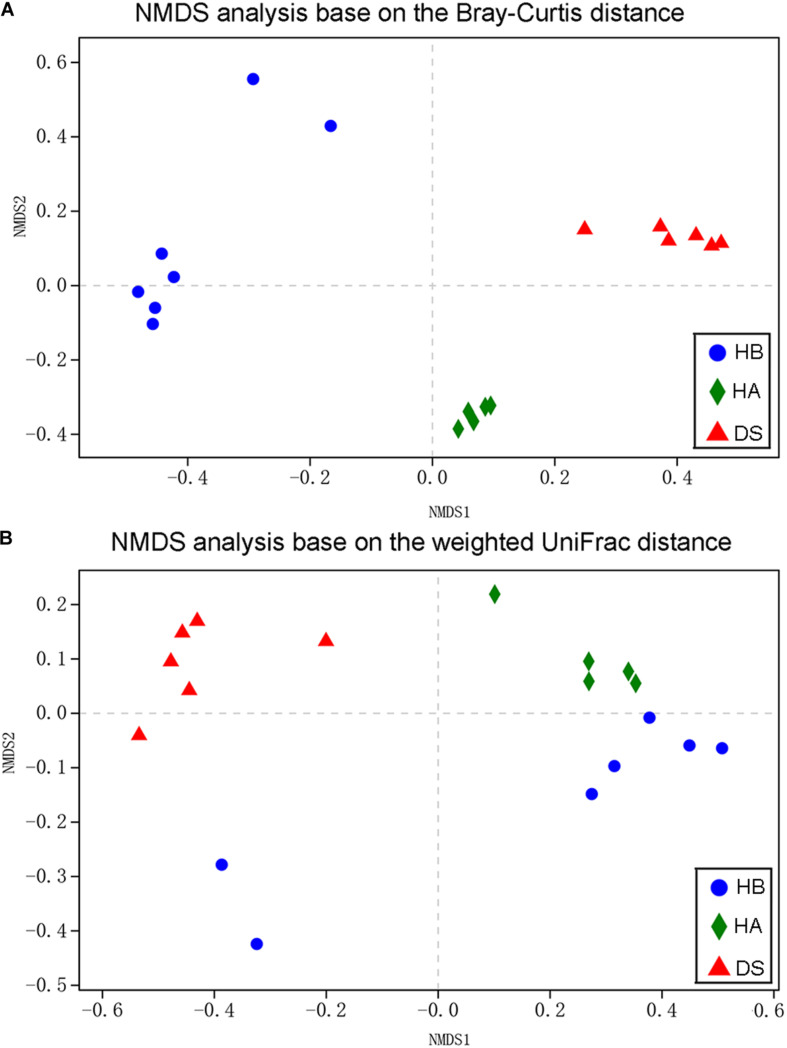
Bacterial community variation among brown frogs of diarrhoeic and healthy groups. Non-metric multidimensional scaling based on all OTUs shows patterns of division by health status (red: DS; green: HA; blue: HB) based on the Bray–Curtis (A) and weighted UniFrac (B) distance. Each point represents the microbial community of a brown frog in a given group.